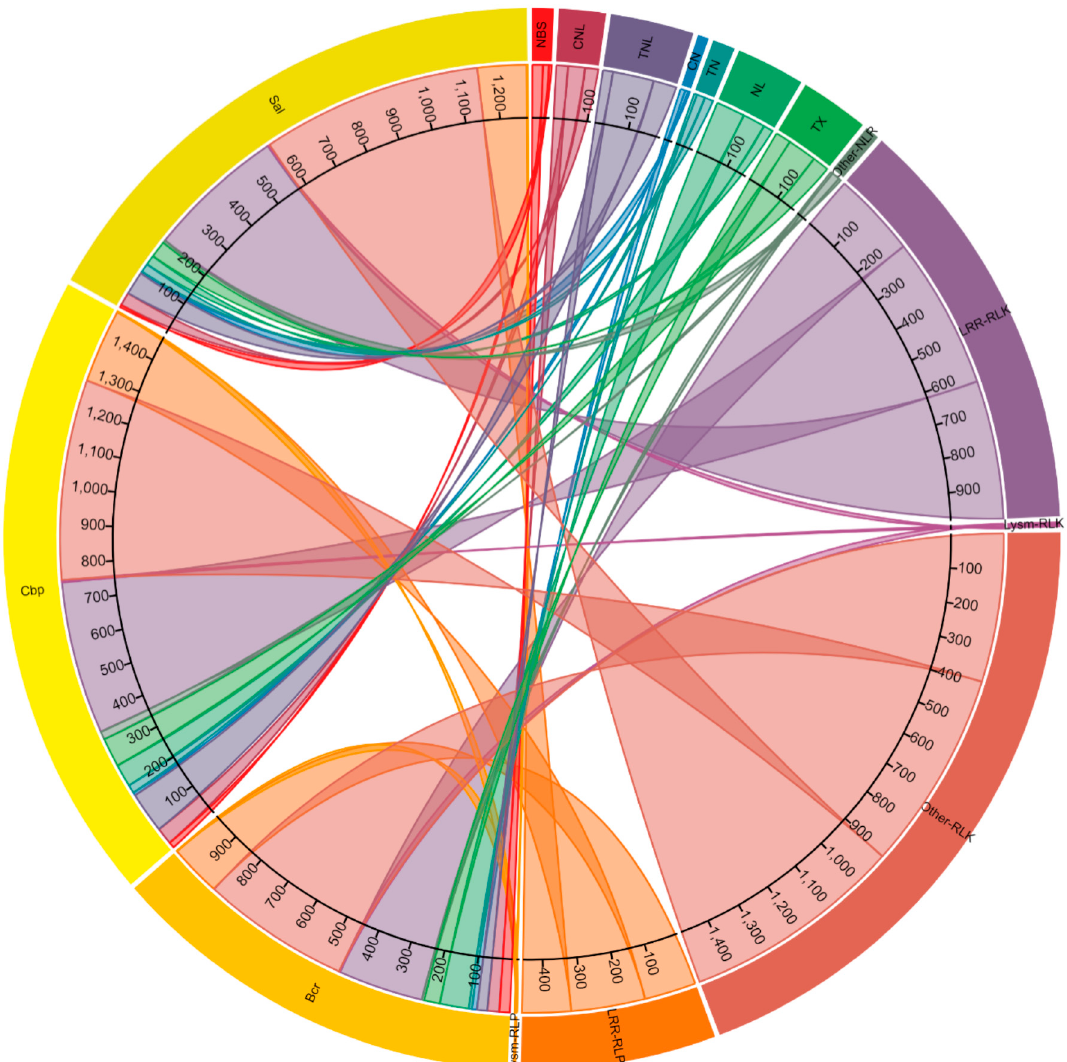
Figure 1. The number and distribution of resistance-gene analog (RGA) subclass nucleotide-binding site (NBS), coiled-coil (CC)-NBS or CN, CN-leucine rich repeats (LRR) or CNL, NBS-LRR or NL, Toll/Interleukin-1 receptor (TIR)-NBS-LRR or TNL, TIR-NBS or TN, TIR with unknown domains or TX, NBS-LRR with other domains or Other-NLR, LRR- receptor like kinase (RLK) or LRR-RLK, Lysin motif (LsyM)-RLK or LysM-RLK, RLK with other receptor or Other-RLK, LRR- receptor-like protein (RLP) or LRR-RLP and LysM-RLP in Brassica cretica (Bcr), Capsella bursa-pastoris (Cbp) and Sinapis alba (Sal) genomes.